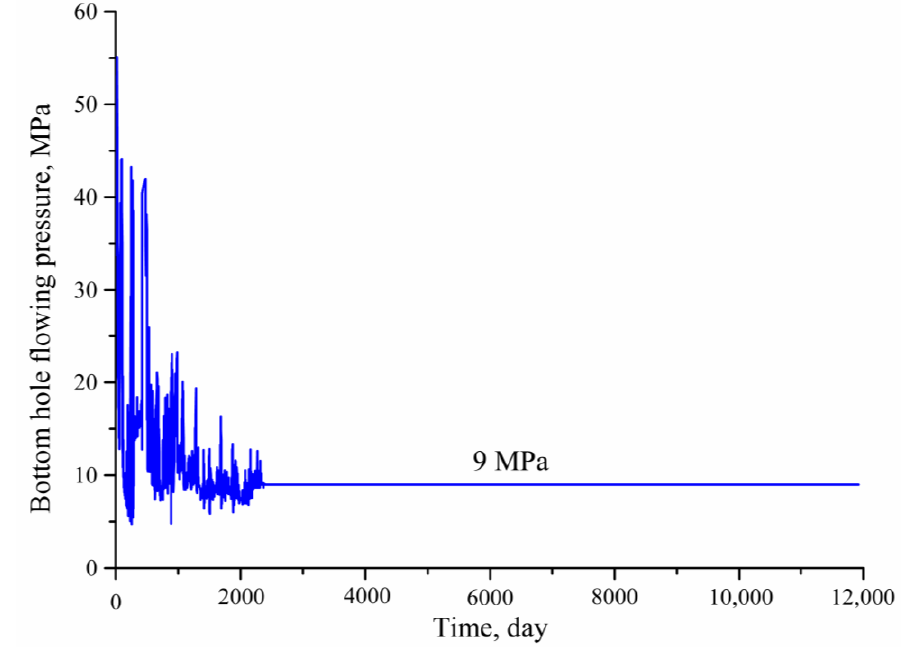
Figure 12. Schematic diagram of production pressure settings.